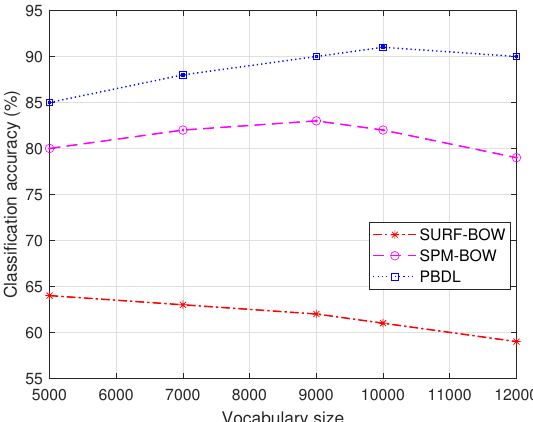
Figure 8. Comparing the performance on WHU-RS dataset with SURF-BOW [31], SPM-BOW [14], and